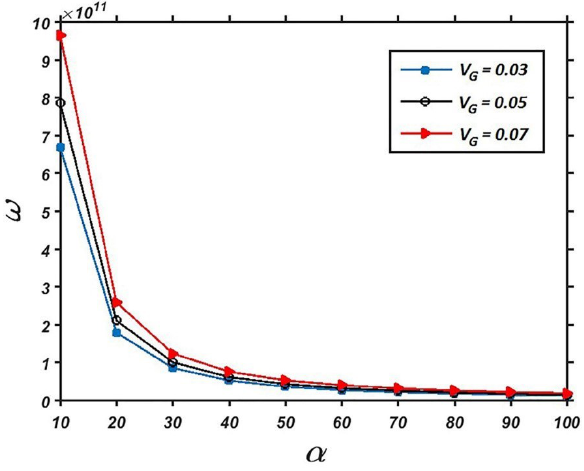
Figure 4: Variation of lamina natural frequency with α parameter for different graphene volume